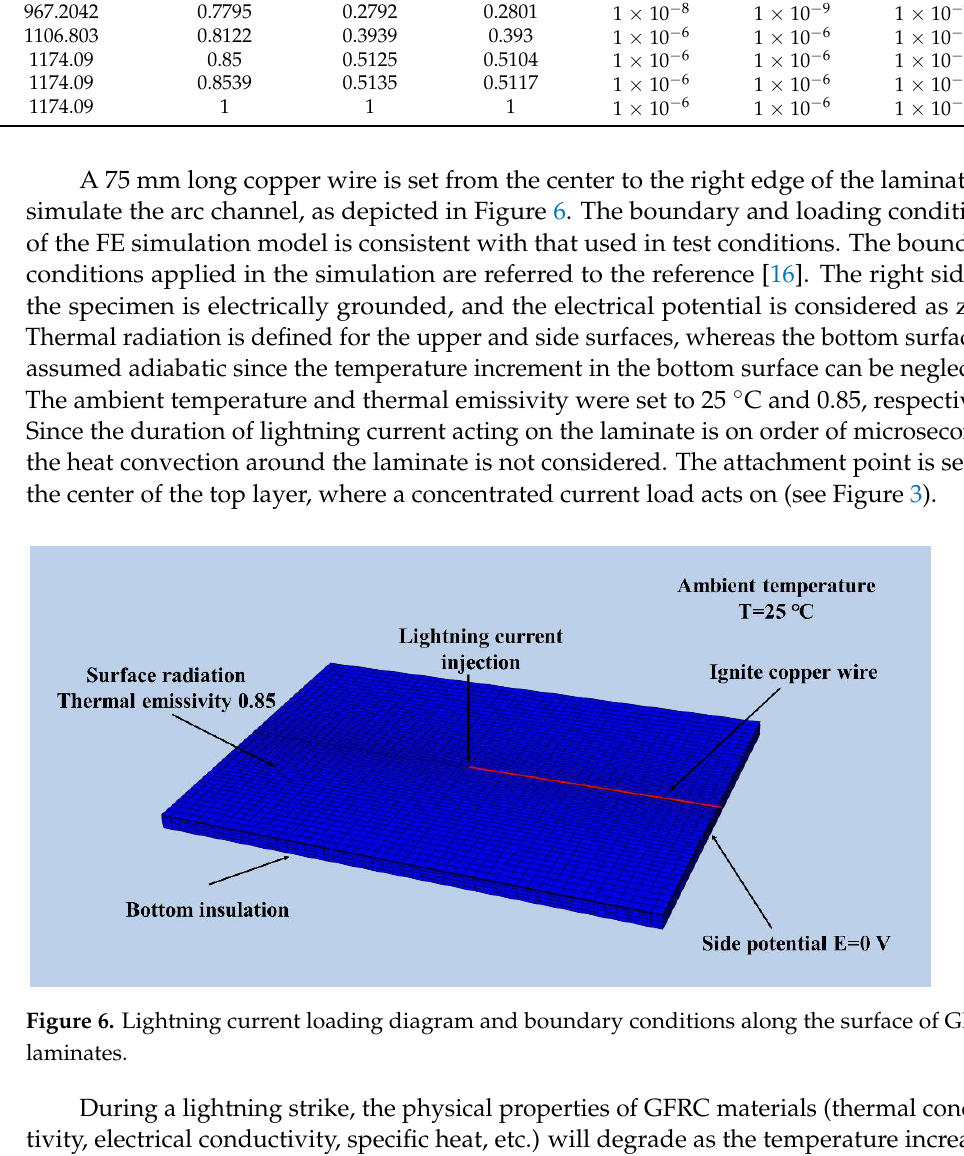
Table 1. Physical properties of GFRC materials.